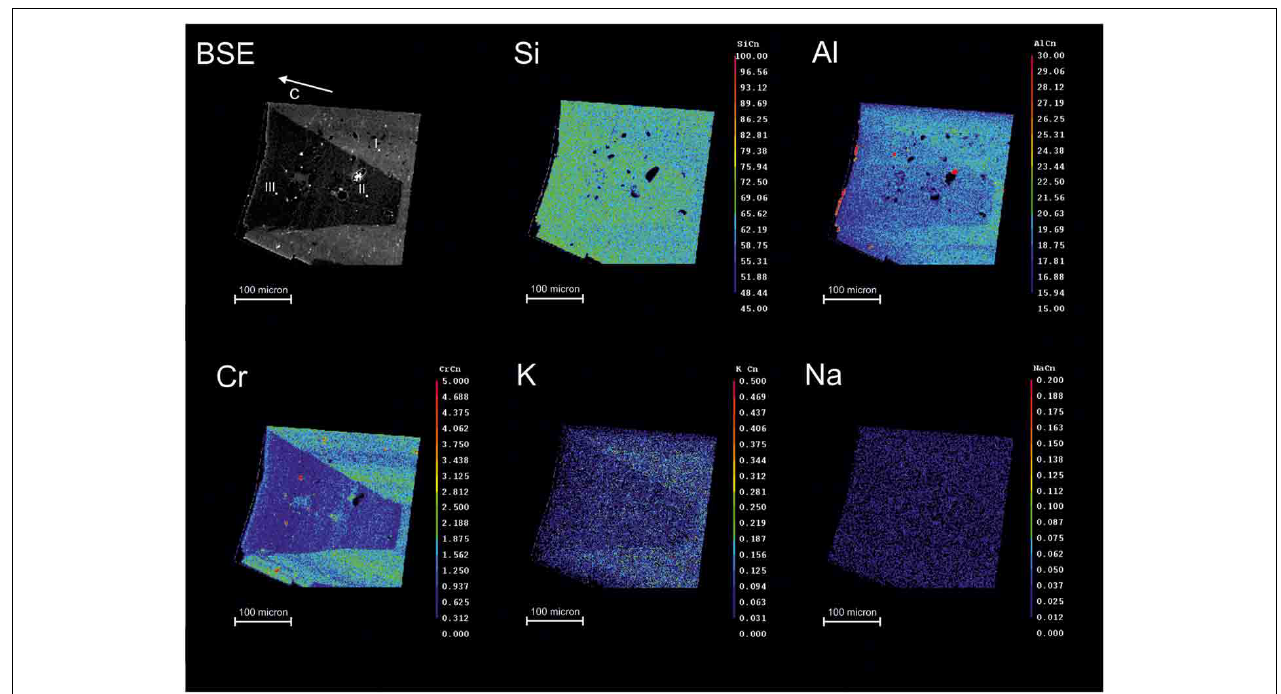
FIGURE 2 | EMPA-WDS maps of selected elements for the untreated beryl sample; the grain was oriented parallel to [001] using its prismatic morphology. The color scale is proportional to element concentration. Analytical spots for Table 1 are reported.